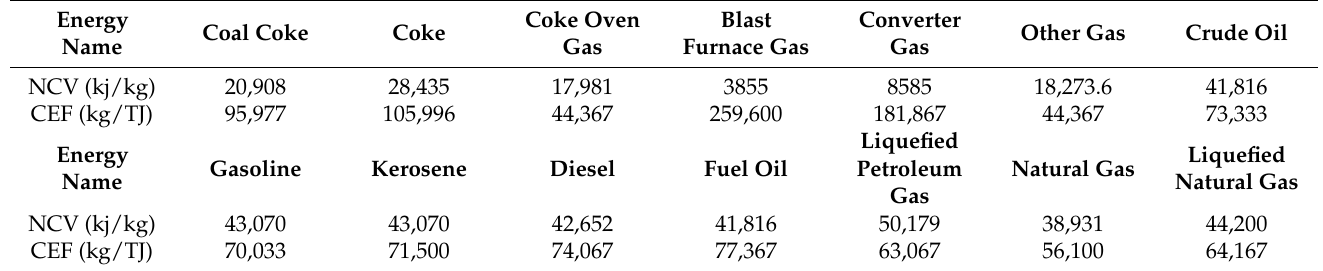
Table 1. NCV and CEF parameter values.